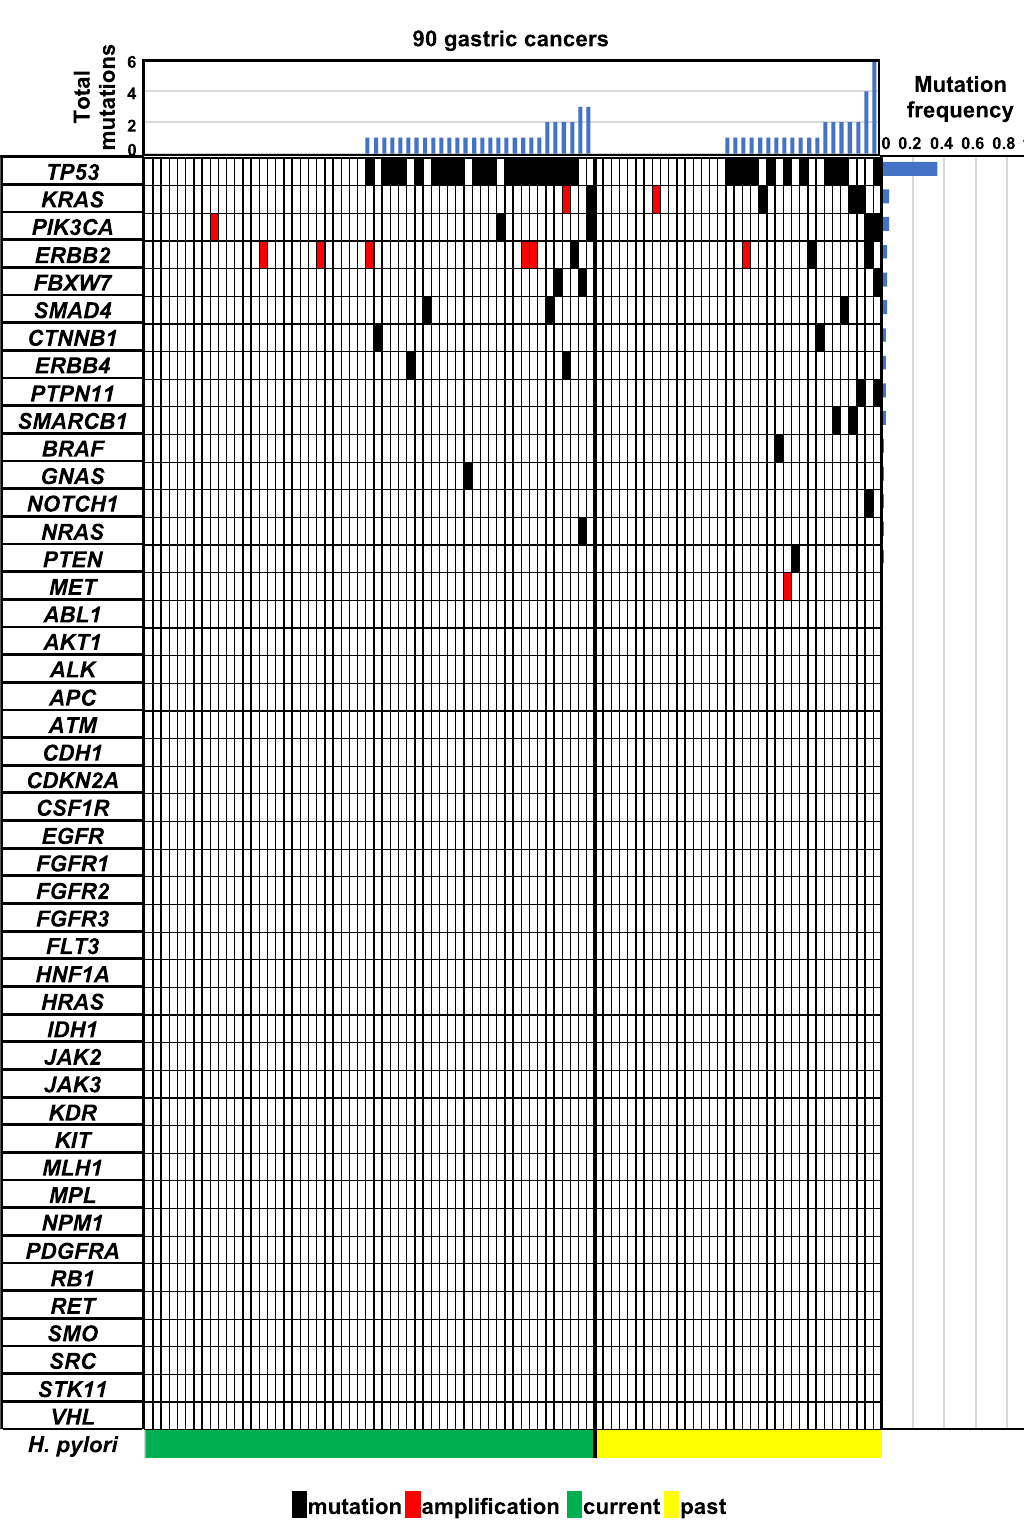
Figure 1. Profiles of genetic alterations in 90 gastric cancers. Genetic alterations of 46 cancer-related genes were analyzed by next-generation target sequencing. Among the 90 gastric cancers, 47 cancers had 68 somatic point mutations of 15 different genes, such as TP53 , KRAS , and PIK3CA . Ten cancers had gene amplification of one of ERBB2 , KRAS , PIK3CA , and MET . Gastric cancers in individual groups and genes analyzed were aligned in the order of the number of total mutations and mutation frequency, respectively. Black and red boxes show somatic point mutations and gene amplifications, respectively. Gastric cancers with current and past infection had comparable profiles of somatic point mutations and gene